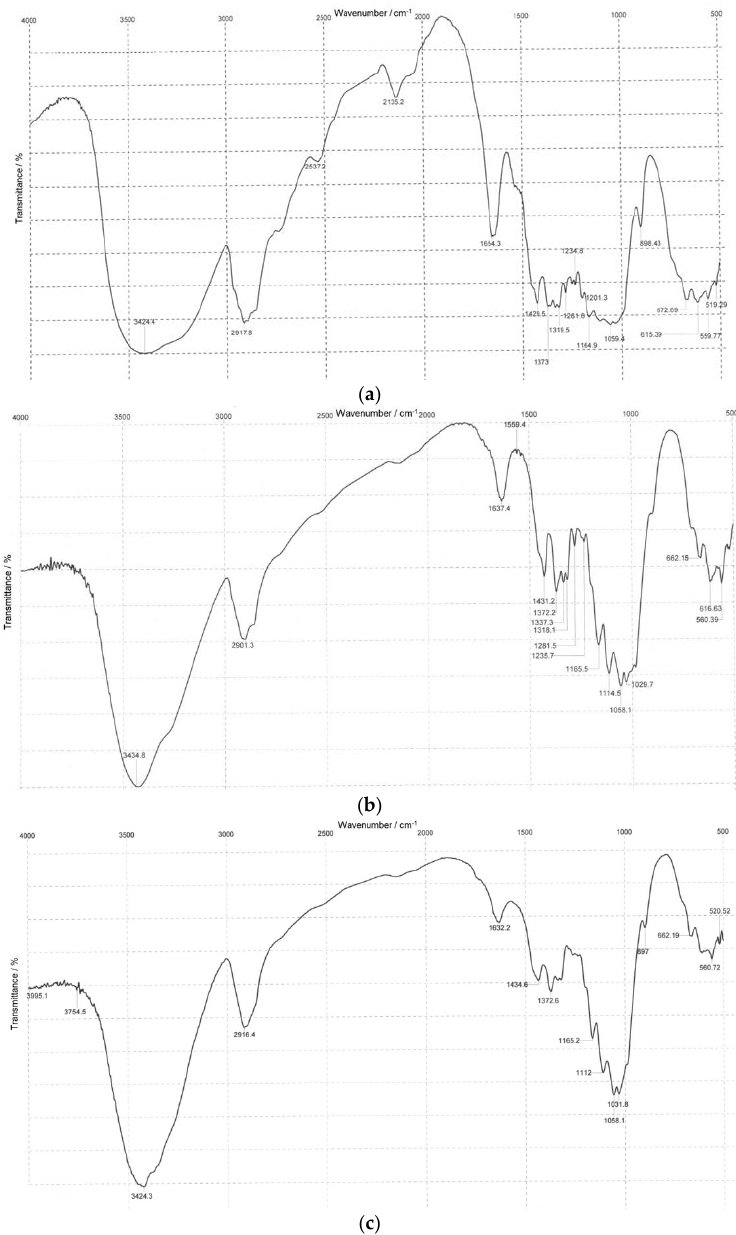
Figure 2. IR spectra of ( a ) BC, ( b ) synthetic cellulose, and ( c ) Miscanthus cellulose.